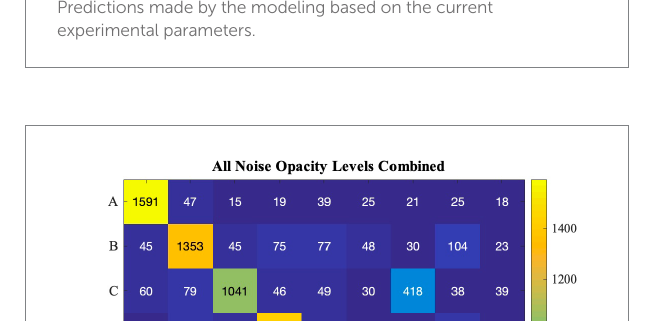
FIGURE 9 Predictions made by the modeling based on the current experimental